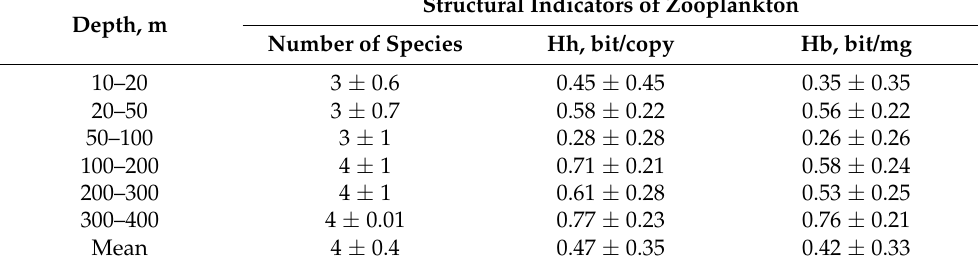
Table 9. The diversity of zooplankton on the Shannon–Weaver index in the eastern section of the Middle Caspian, May